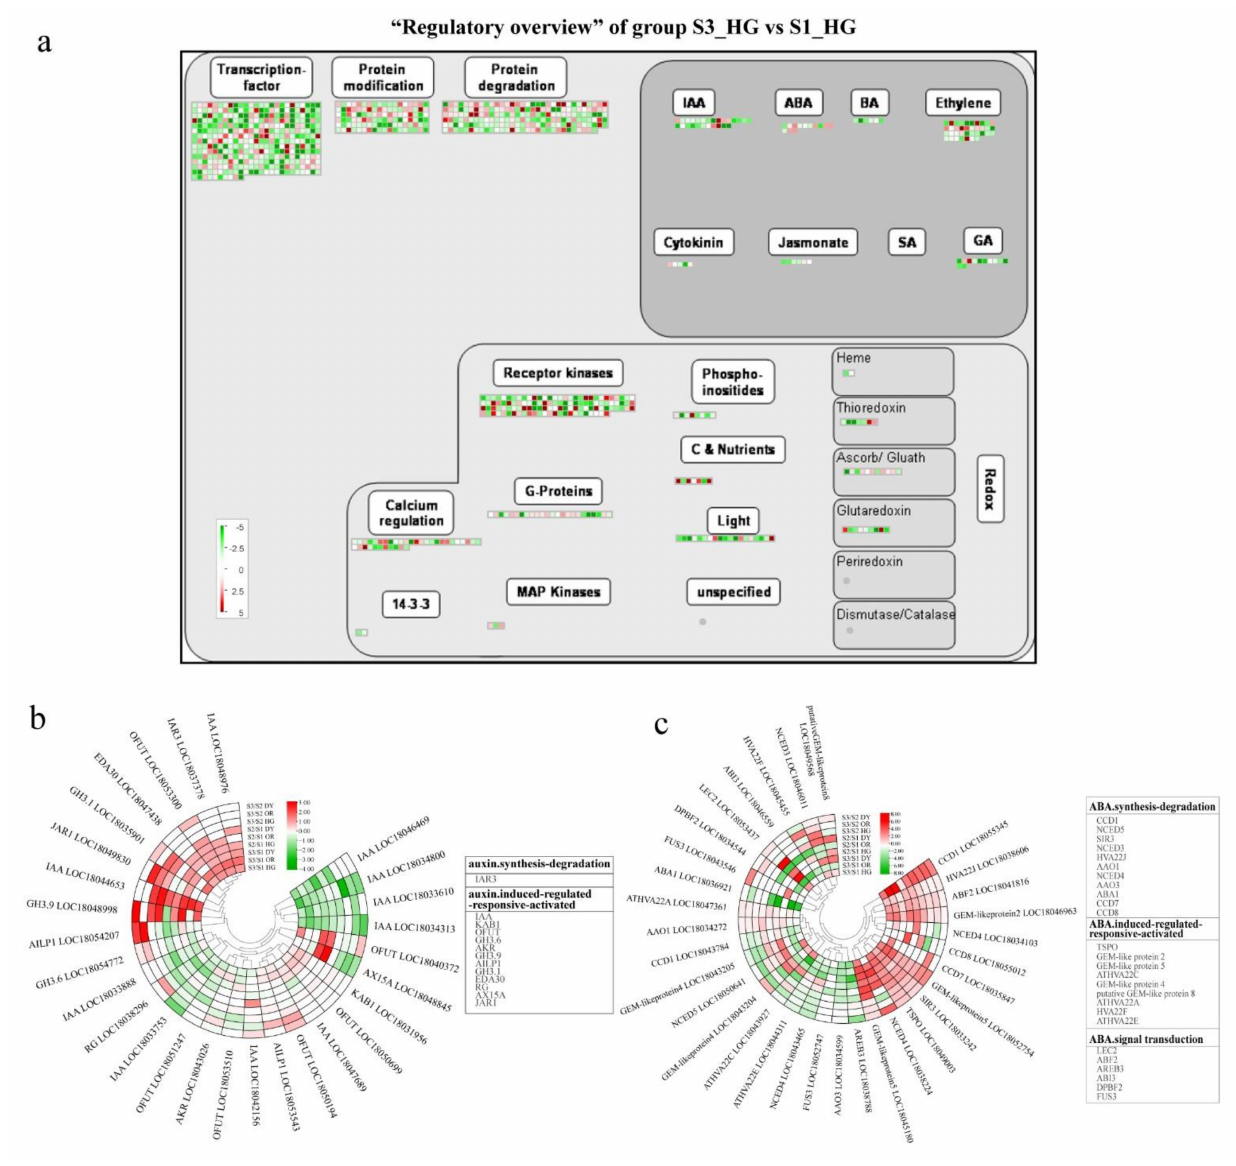
Figure 9. ( a ) MapMan-based “regulatory overview map” of the “S3_HG vs. S1_HG” group of DEGs, including transcription-factors, phytohormones, protein modification, protein degradation, receptor kinases, calcium regulation, G-protein, and C & Nutrients modules. The small heat map in each section of the figure shows the DEGs mapped to the pathway, with a small square indicating a gene. The color of the square indicates the expression of that gene at stage 3, with green showing down- regulation and red showing up-regulation. Plant hormone-related differentially expressed genes during development and ripening in tangor citrus: ( b ) auxin; ( c ) abscisic acid; red and green represent up- and down-regulation, respectively. Heatmap of DEGs was drawn using the log 2 Foldchange value obtained from the pairwise comparison of samples. S3/S1, comparison group of S3 and S1; S2/S1, comparison group of S2 and S1; S3/S2, comparison group of S3 and S2. Red and green indicate up-regulation and down-regulation, respectively, in the former of the